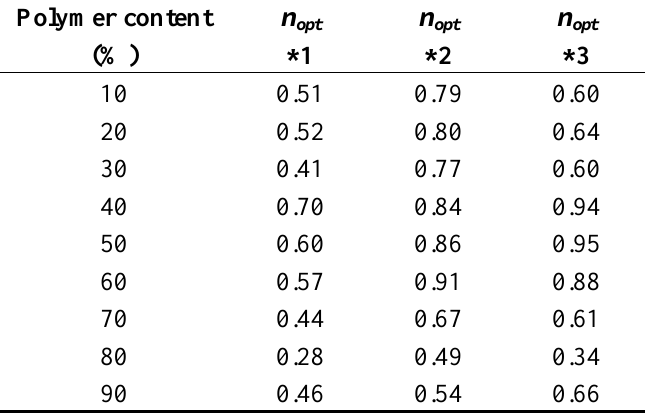
Table 2. Optimum value, n given polymer content (%). Condition *1 :   =  , and  